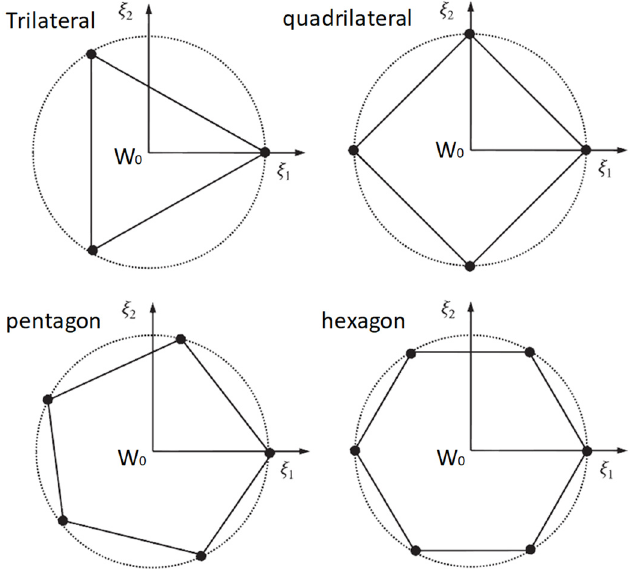
Figure 5. Four kinds of regularized polygon elements.